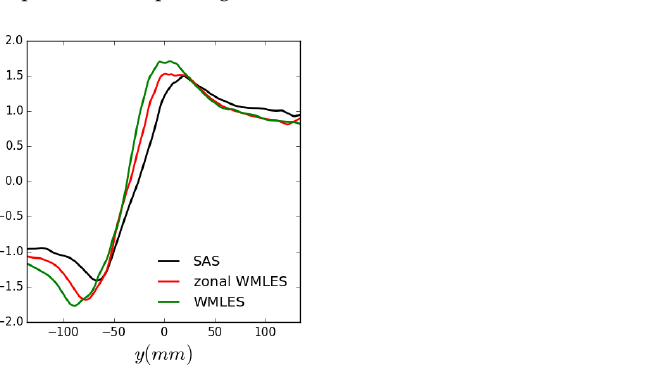
Figure 10. Phase-averaged pressure over Line 1 with different turbulence modeling techniques, ( a ) SAS, ( b ) zonal WMLES , ( c ) WMLES, ( d ) comparison over line at instance B. Instances A and B correspond to RVR passing Line 1.